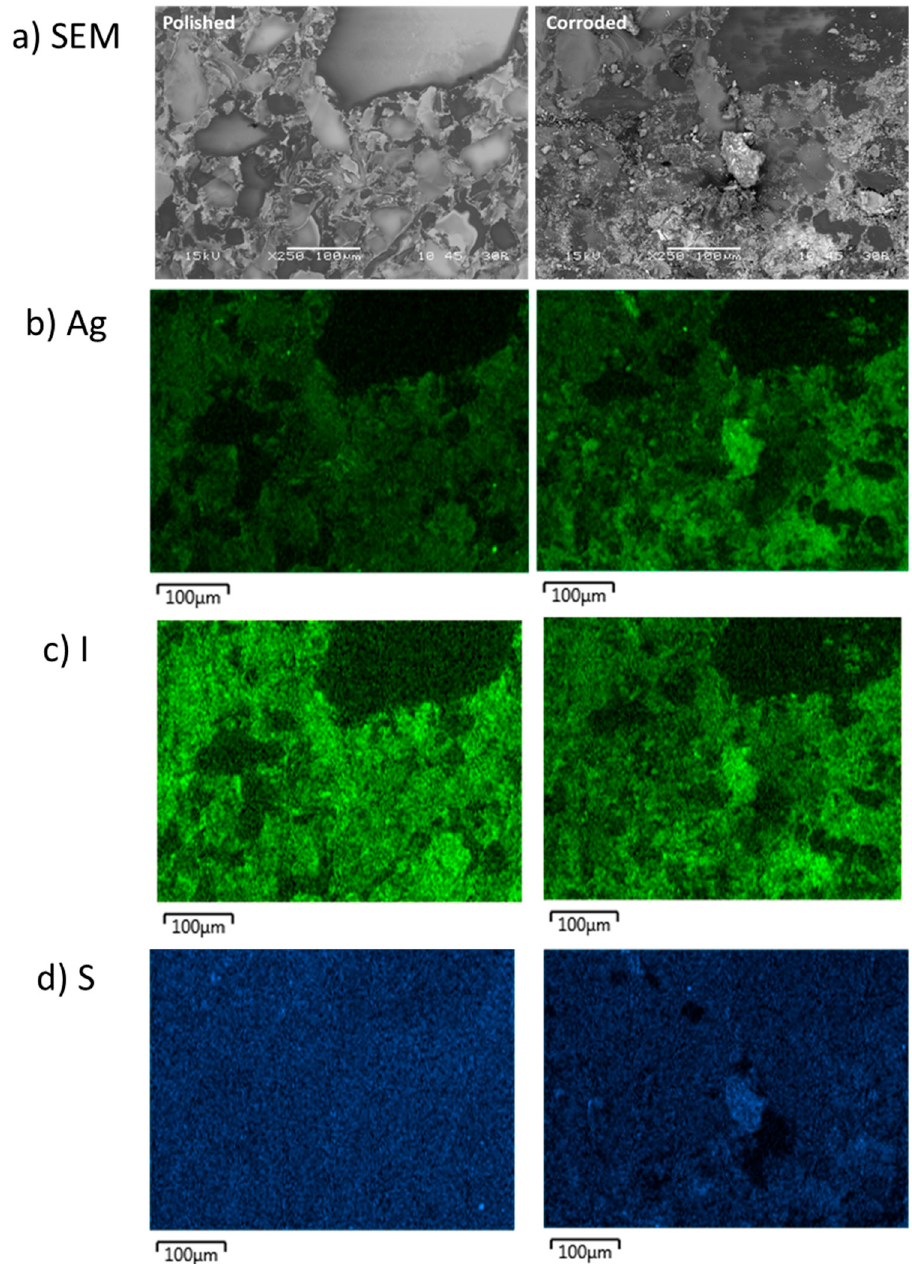
Figure 15. ( a ) SEM micrographs of the SPS-1 sample (left) before and (right) following SPFT testing at pH 11; and the corresponding EDS maps of: ( b ) Ag; ( c ) I; and ( d ) pH 11; and the corresponding EDS maps of: ( b ) Ag; ( c ) I; and ( d ) S.